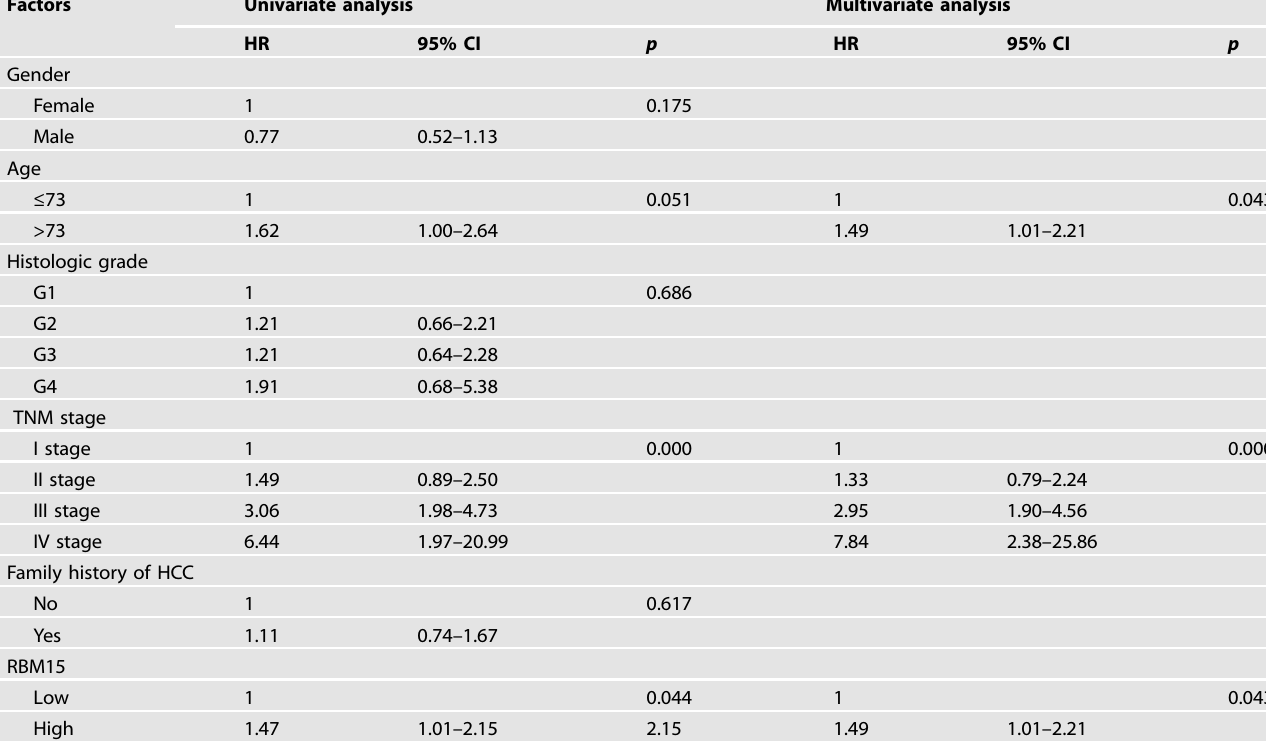
Table 2. Univariate and multivariate Cox analysis of cohort-2 (training cohort) for overall